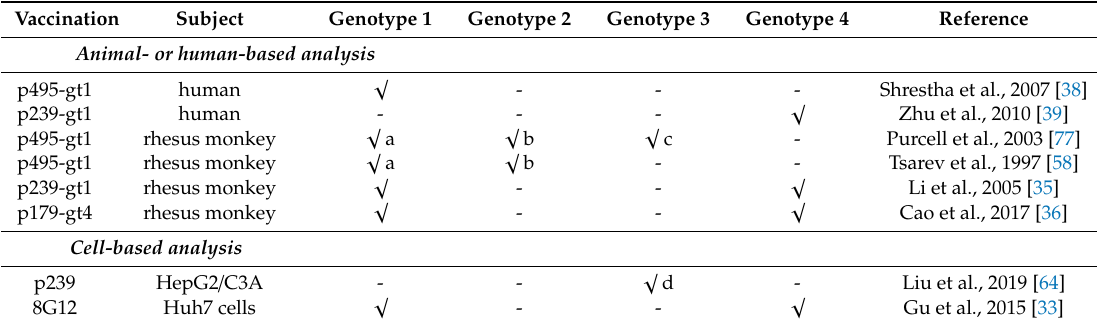
Table 3. The protection of the hepatitis E vaccine among di ff erent virus